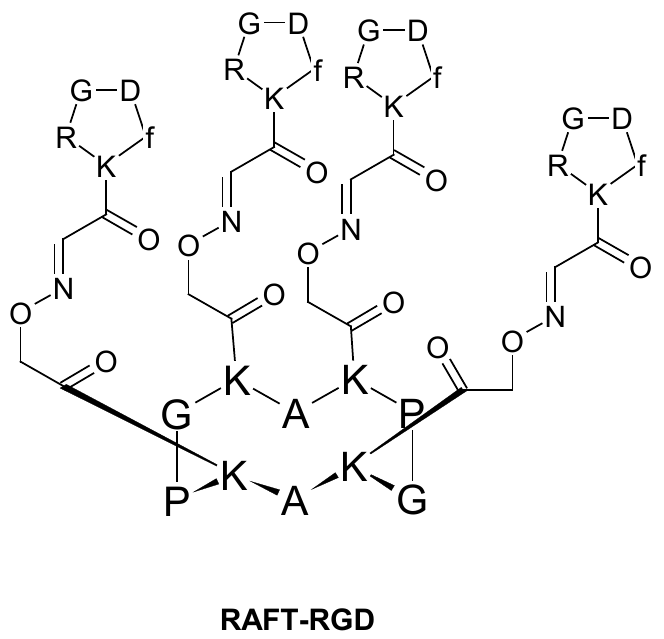
Figure 2. Chemical structure of RAFT-RGD